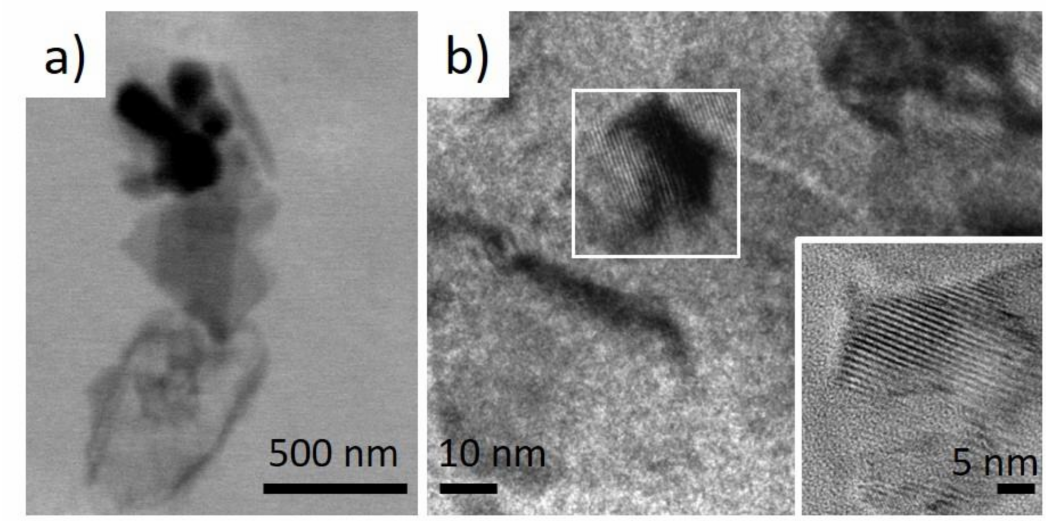
Figure 5. ( a ) low-resolution TEM image of the selected micro-fragment of the I. basta skeletal fiber- containing nanoparticles and ( b ) high-resolution TEM images showing their crystalline nature.